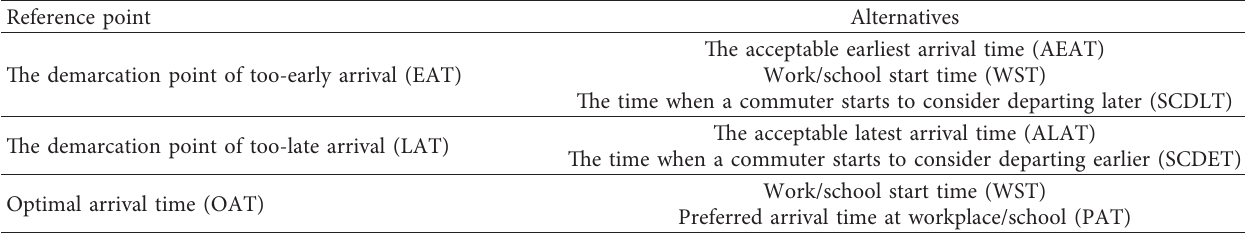
Table 1: Alternatives for each reference